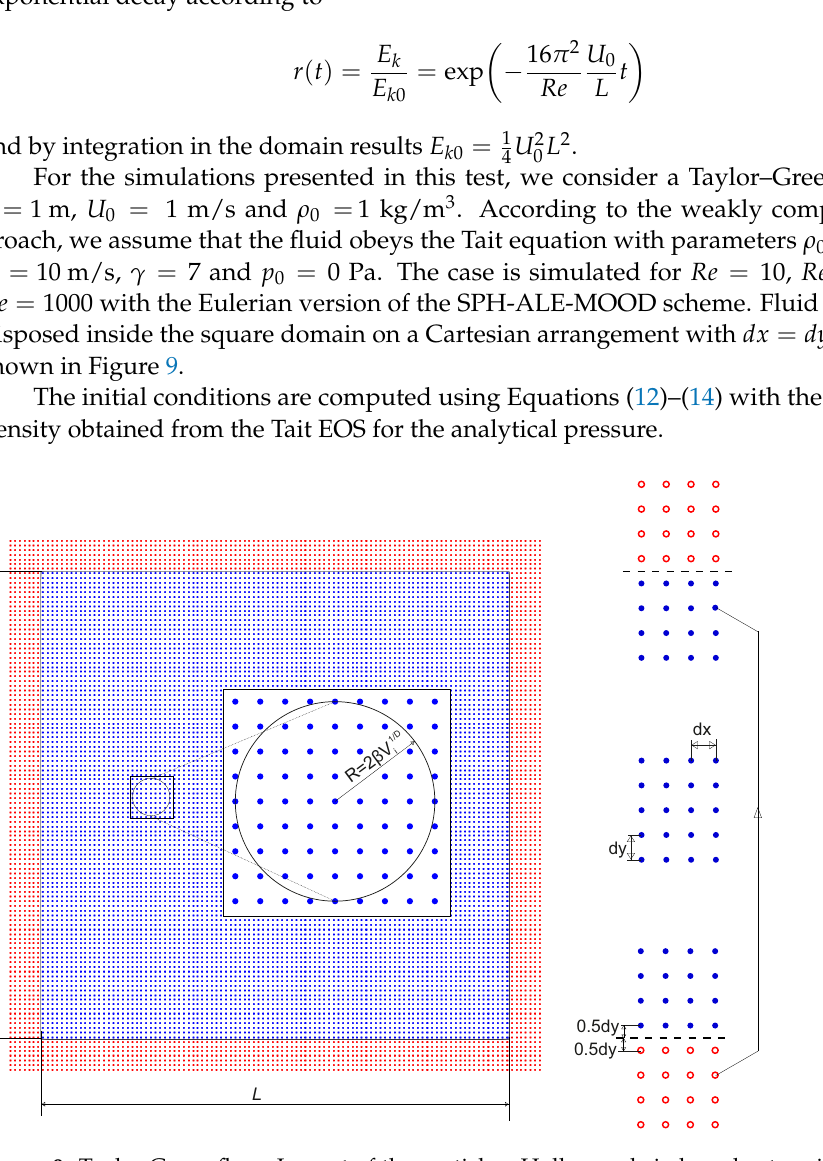
Figure 9. Taylor Green flow: Layout of the particles. Hollow red circles: ghost periodic particles. Solid blue circles: fluid